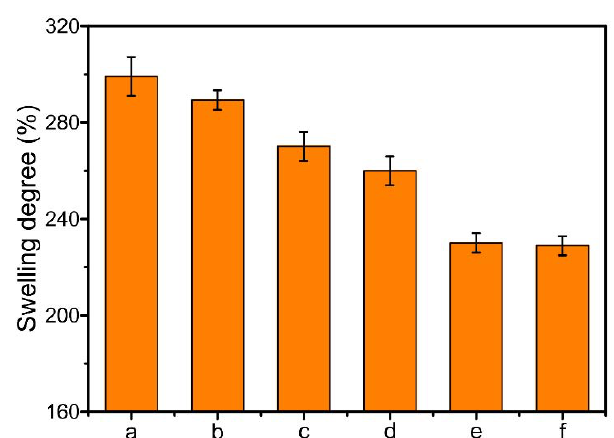
Figure 5. Swelling degree of drug ‐ loaded nanofibrous membranes: ( a ) CS/PVA nanofibrous membrane, ( b ) CS/PVA/GO nanofibrous membrane, ( c ) CS/PVA/CipHcl nanofibrous membrane, ( d ) CS/PVA/GO/CipHcl nanofibrous membrane, ( e ) CS/PVA/Cip nanofibrous membrane, ( f ) CS/PVA/GO/Cip nanofibrous membrane.